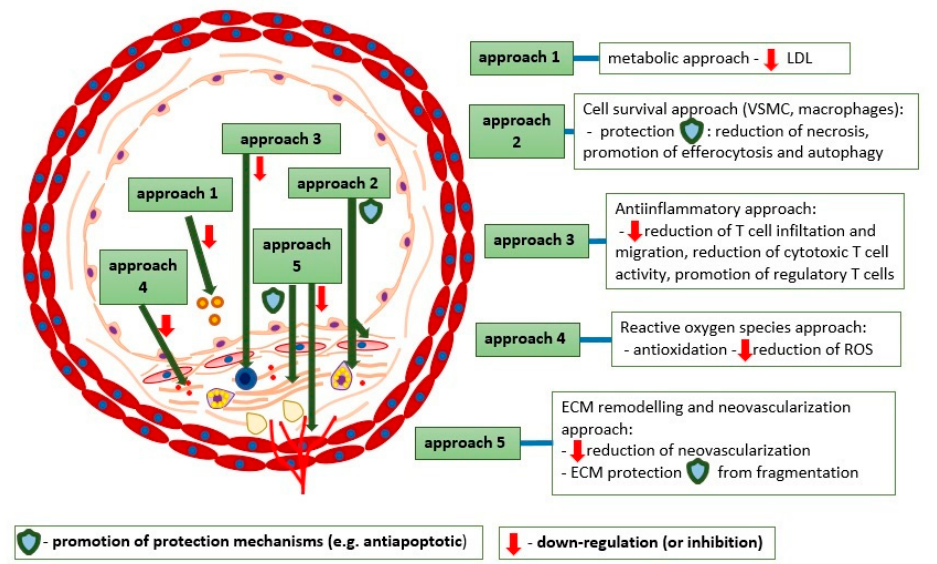
Figure 3. The approaches towards atherosclerotic plaque stabilization therapy and their molecular aspects.